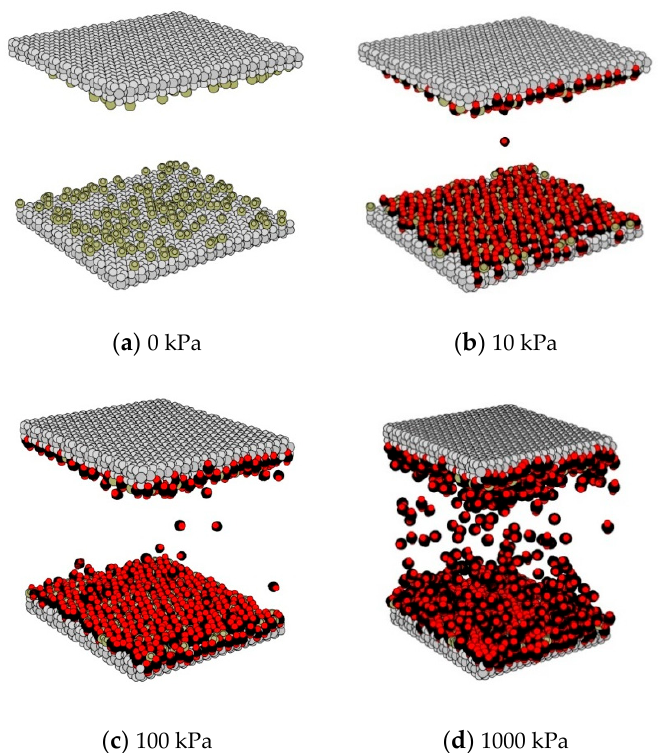
Figure 13. Snapshots of CO 2 molecules in heterogeneous porous glass of 2 nm . In widths at 283 K and 20% of the functional groups . In these figures, the large and small grey spheres represent the solid model of SiO 4 crystals, the large green spheres and small green spheres represent the oxygen atoms and the hydrogen atoms of OH group, respectively, and the large black spheres and small red spheres represent the carbon atoms and oxygen atoms of the CO 2 molecules, respectively .